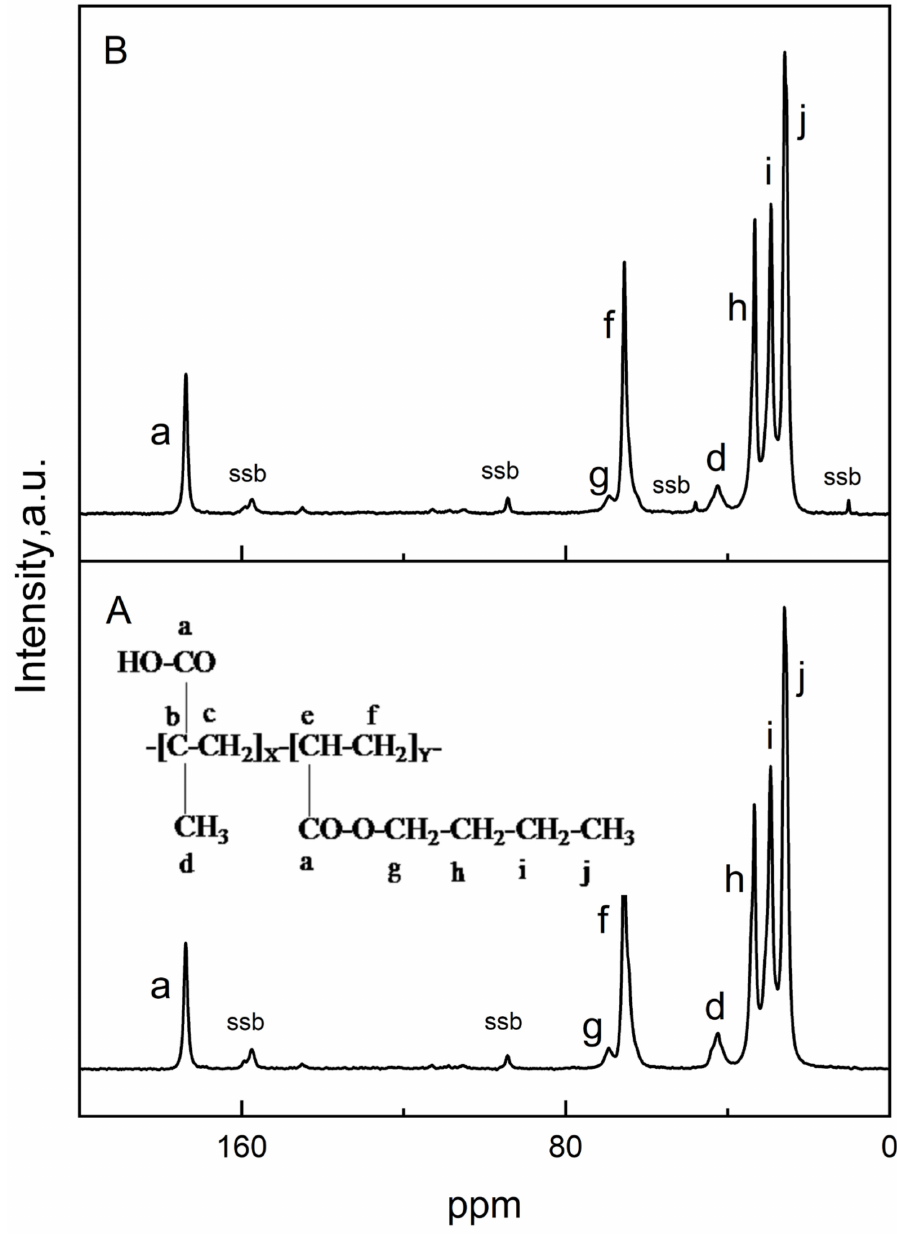
Figure 4. Solid-state 13 C NMR CP-MAS spectra of Mat 2 ( A ) and Nano 6 ( B ), in which ssb = spinning